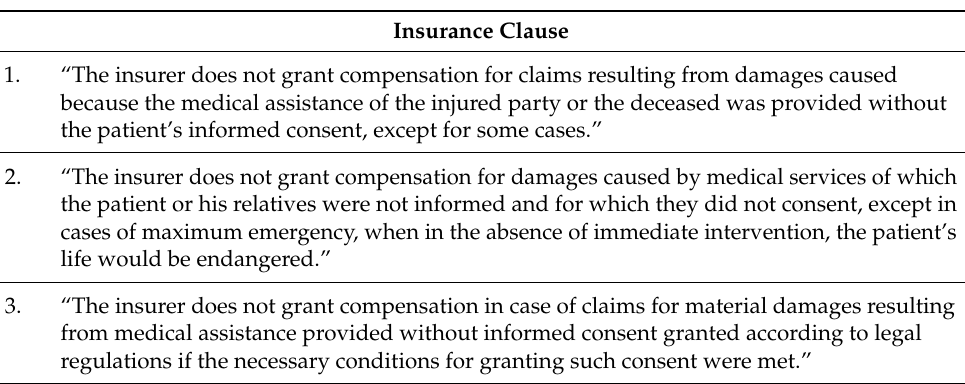
Table 3. Exclusion clauses in insurance agreements in